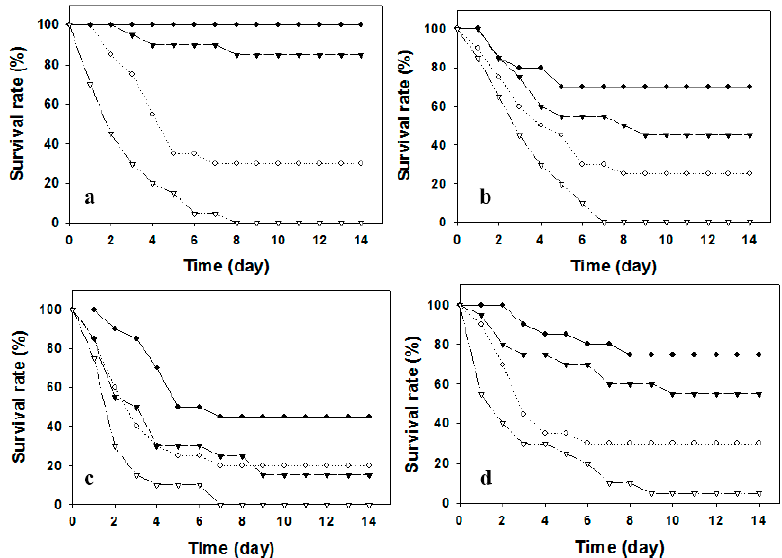
Figure 1. The kinetics of survival rates of silver sea bream ( N = 30–33) against virulent Vibrio alginolyticus challenges after immunization with formalin-killed bacterins through ( a ) i.p. + i.p.; ( b ) i.p. + imm.; ( c ) imm. + imm.; and ( d ) oral administration routes. ( ⎯ , vaccinated fish, and ⋅⋅⋅ , control, both groups were challenged i.p. with the bacterial dose of 5.0 × 10 5 cfu/fish; -- , vaccinated fish, and ∇ - ⋅⋅ - ∇ , control, both groups were challenged i.p. with the bacterial dose of 5.0 × 10 7 cfu/fish).